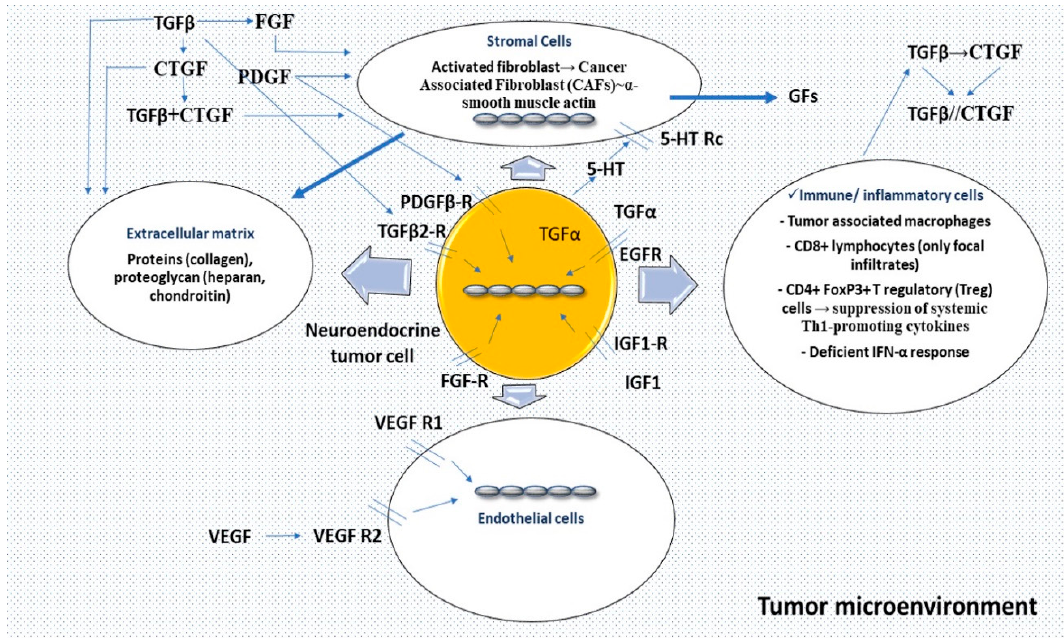
Figure 2. Tumor microenvironment represents an important functional unit comprising a cluster of endothelial and inflammatory cells, and mesenchymal stroma elements with fibroblasts interconnected and interacting. An initial event, an injury, induces fragmentation of extracellular matrix elements, chemo-attractant molecules with recruitment of immune cells acting as a pro-tumorigenic environment, followed by pro-angiogenic elements. In specific circumstances, serotonin (5-HT) via a receptor (5-HT Rc) may be mitogenic in stroma cells acting through a TGF β -mediated mechanism or potentiating the effects of PDGF, β -FGF, or EGF and insulin. TGF- β represents a pro-fibrotic mediator; TGF β 1 and the receptor subtype-2 (TGF β r2) have been identified in SI-NEN. CTGF is transcriptionally activated principally through TGF β 1, acting as a downstream mediator of its profibrotic activities on fibroblasts; PDGF, EGF and FGF are also activating CTGF gene expression at the transcriptional level. PDGF is a mitogen for the fibroblasts and the smooth muscle cells. Infiltration of immune cells is not high in SI-NENS, but tumor-associated macrophages suppress the adaptive immune system and stimulate fibrosis by secretion of profibrotic factors such as TGF β . Abbreviations: 5-HT: 5-hydroxytryptamine; 5-HT Rc: 5-hydroxytryptamine receptor; TGF β : transforming growth factor- β ; PDGF: platelet-derived growth factor; β -FGF: β -fibroblast growth factor; EGF: Epidermal growth factor; TGF β r2: transforming growth factor- β receptor subtype-2; CTGF: connective tissue growth factor; CAF: cancer-associated fibroblast; GFs: growth factors; IGF-1: insulin growth factor type 1; VEGF: vascular endothelial growth factor; VEGF R: vascular endothelial growth factor receptor; CD8: cluster of differentiation 8; CD4: cluster of differentiation 4; FoxP3: forkhead box P3; Th1: T helper type 1; IFN- α : Interferon alpha.